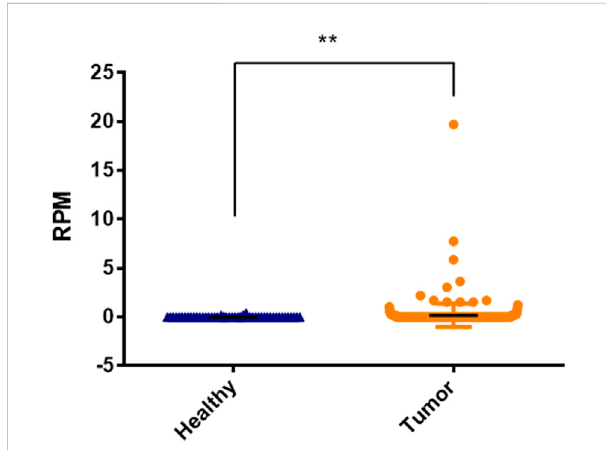
FIGURE 7 Signi fi cantly expressed differences of hsa-miRNA-3180 between healthy and disease samples of hepatocellular cancer.